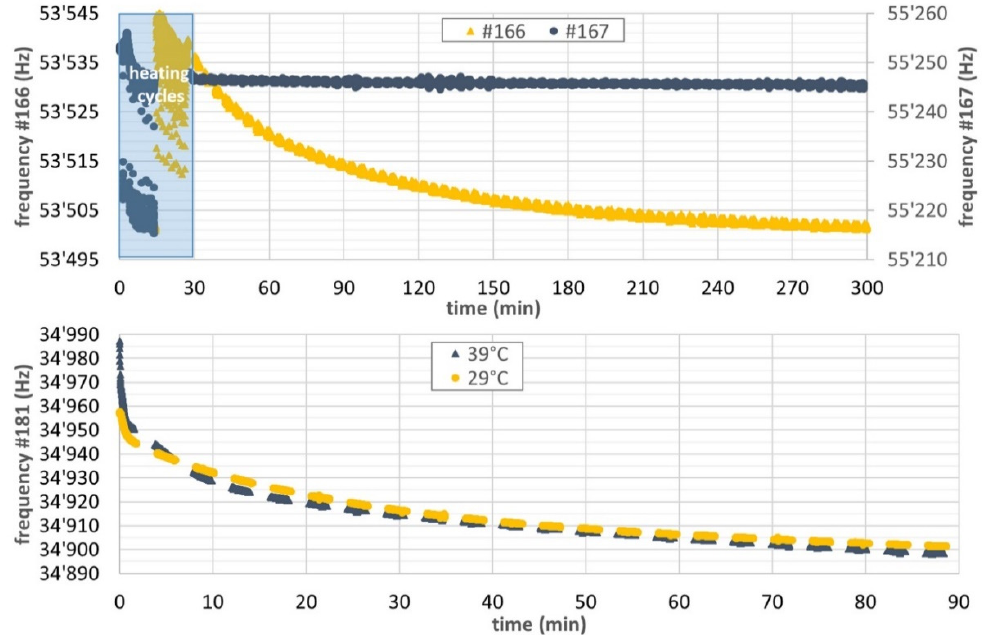
Figure 12. Top : Frequency responses of the MCM-48 coated cantilever #166 and a pristine cantilever # 167 exposed to 30 scc/min of Ar with 100 ppmV H 2 O at 29 °C and 990 mbar. Bottom : CBV100 coated Cantilever # 181 exposed to argon with 100 ppmV H 2 O at 990 mbar, 29 °C and 39 °C.